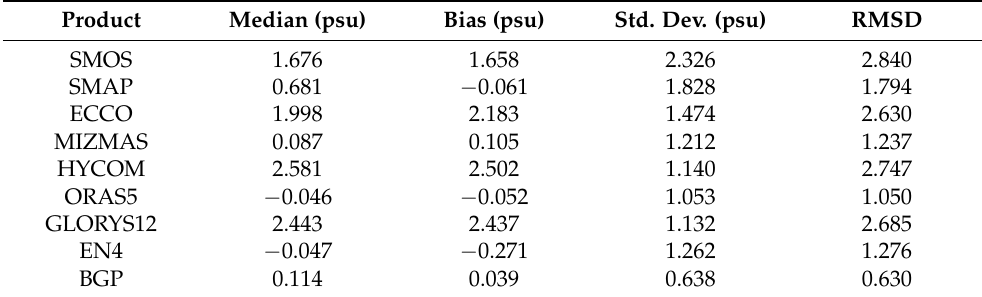
Table 3. Median, mean, standard deviation (Std. Dev.), and Root Mean Square Deviation (RMSD) of SSS differences between products and SIZRS in situ data at each latitude SIZRS measurements were taken.